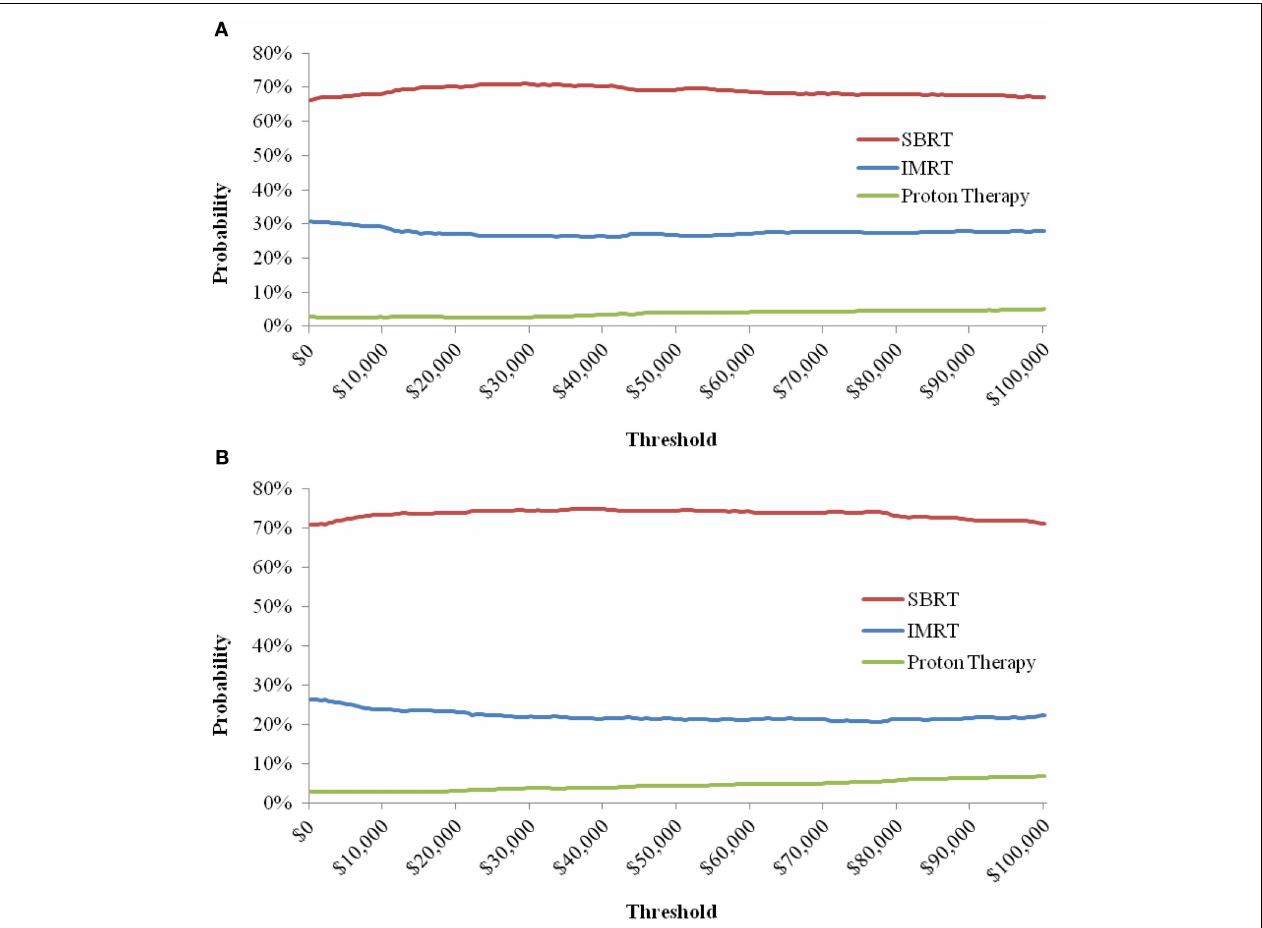
FIGURE 2 | Probability of SBRT being cost-effective when compared to IMRT and ProtonTherapy, from the Payer (A) and Societal (B) Perspective. Note: the cost-effectiveness acceptability curve shows the percentage of iterations in the probabilistic sensitivity analysis that are cost-effective at a certain